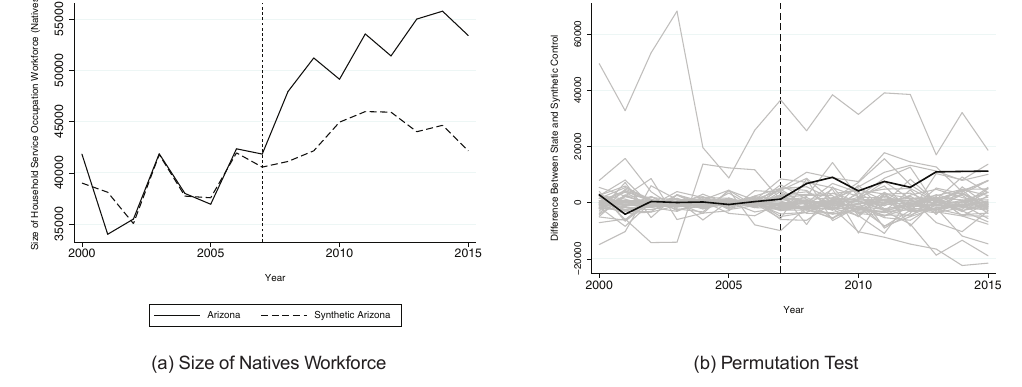
Size of native workforce in household service occupations